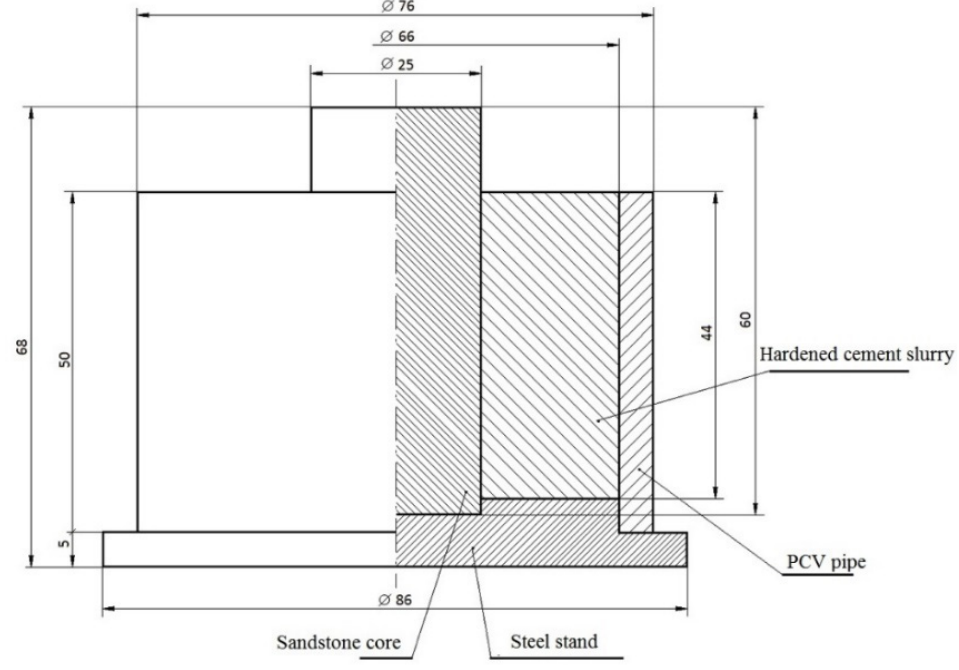
Figure 5. Diagram of a mold with a core and hardened cement slurry [27].